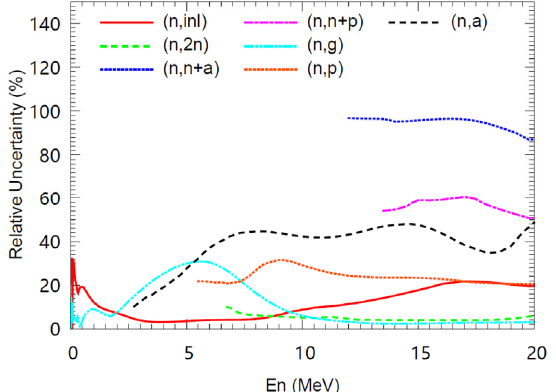
Fig. 6. The uncertainties of seven neutron cross sections of 75 Ge CENDL-3.2.